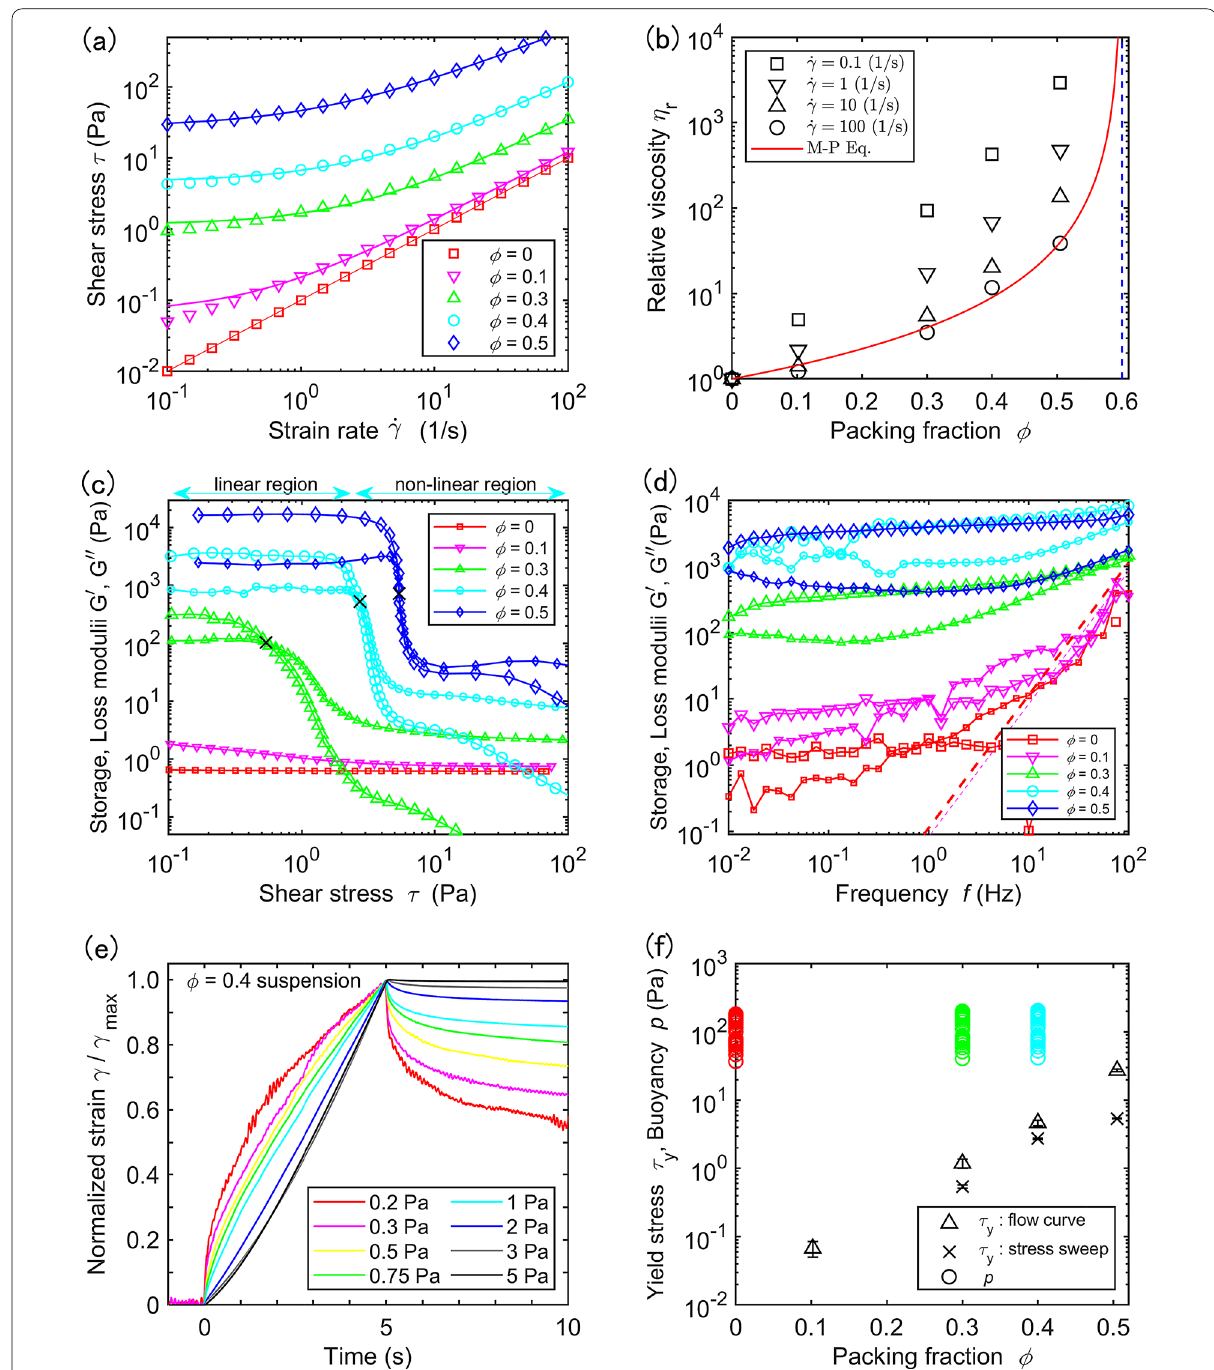
Fig. 1 (See legend on previous